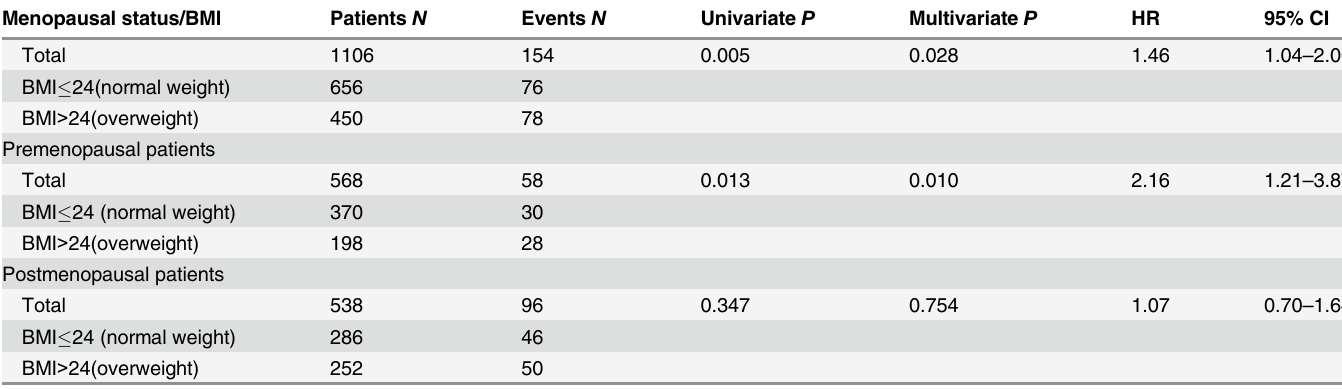
date, two largest pooled analyses supported a negative effect of BMI on survival outcomes in patients with TNBC[25, 26]. Our data provided critical additional evidence for this finding. High BMI might influence TNBC prognosis through various mechanisms, such as obesity- associated comorbidities that interfere with optimal treatment, the effect of higher cholesterol level on tumor metastasis, or other mechanisms. High BMI might cause higher cholesterol lev- els and even fatty liver disease, which would affect implementation or dosing of chemotherapy. Nelson et al. demonstrated that liver X receptor activation by 27-hydroxycholesterol (27HC, a primary cholesterol metabolite) increases tumor metastasis and that these activities occur inde- pendently of ER[27]. Consequently, obesity or OW, which cause higher 27HC levels, could indicate poorer prognosis. Leptin, the adipose tissue cytokine, increases in obesity and pro- motes survival of cancer stem cells in vivo, consequently promoting breast cancer[28]. More- over, Howe et al found out that saturated fatty acids, released as a consequence of obesity- associated lipolysis, induce macrophage activation via Toll-like receptor-4, thereby stimulating